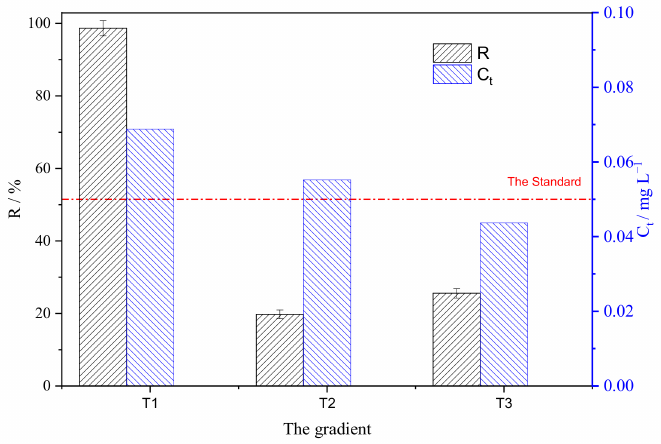
Figure 11. SAIEF solid-liquid ratio conditions of uranium concentration gradient descent